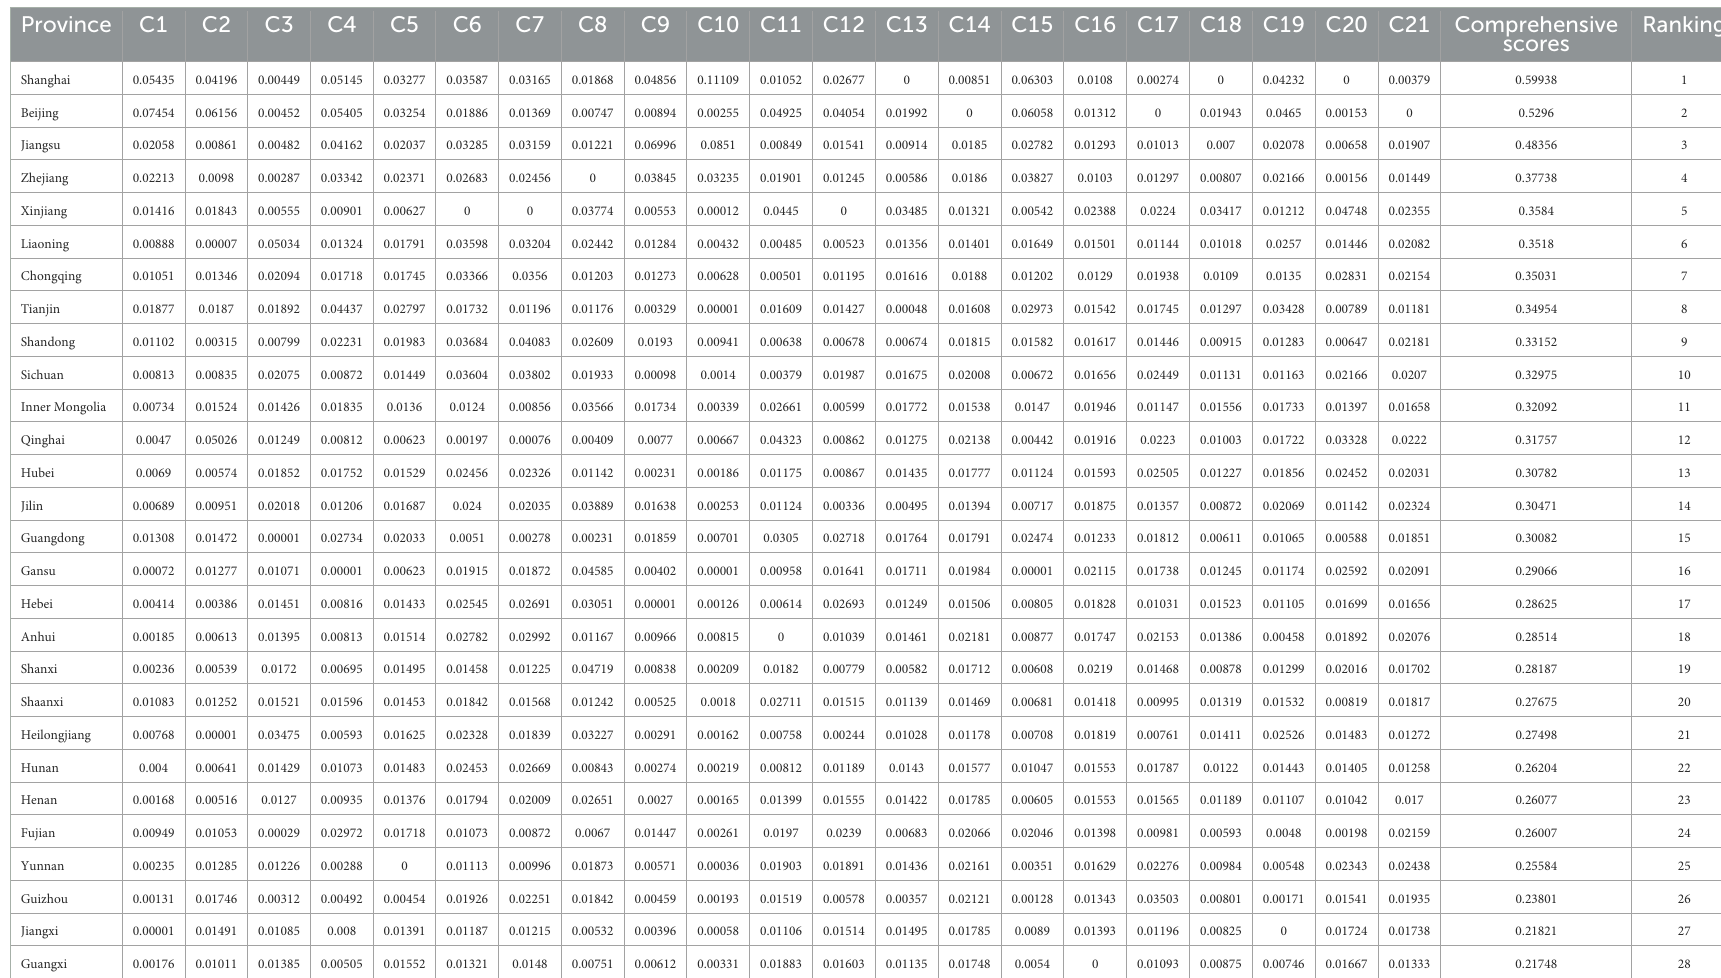
TABLE 6 The score of comprehensive measurement of the degree of social disability risk for 28 provinces (municipalities and autonomous regions) in China in